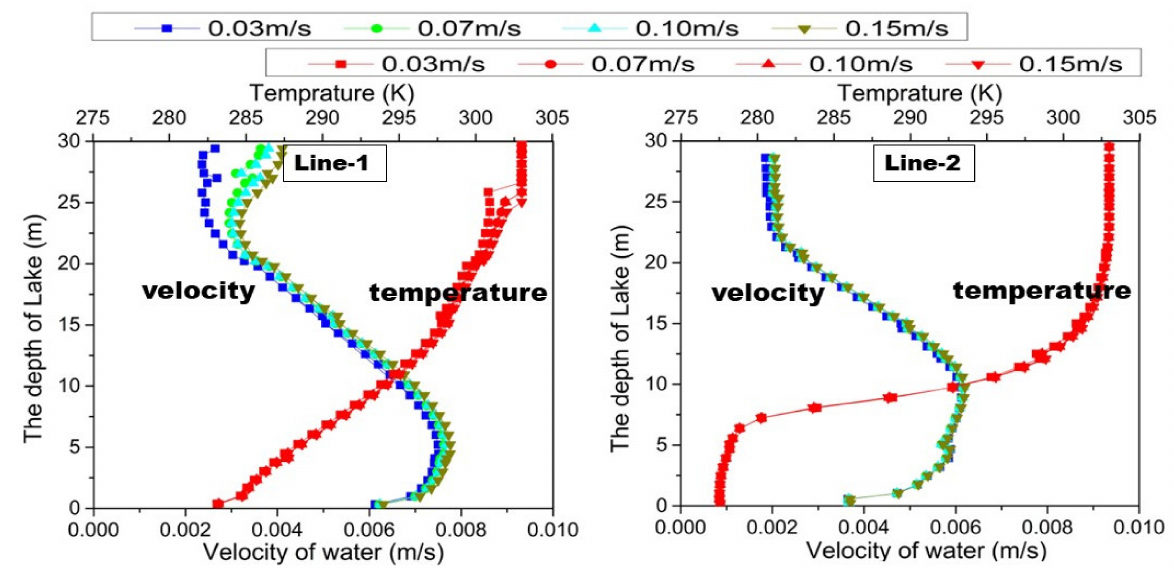
Figure 5. Vertical distribution of water temperature and velocity with different gas inlet velocities in Line 1 and Line 2 produced by